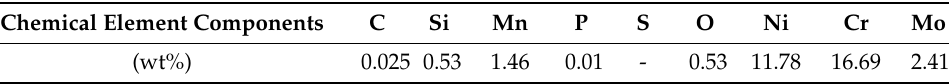
Table 1. Chemical components of 316L stainless steel powder.